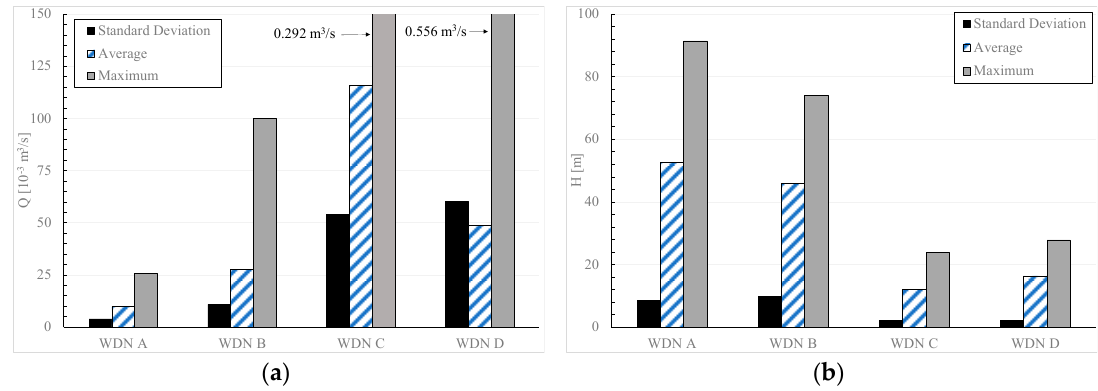
Figure 5. Summary of ( a ) volume flow rate and ( b ) head drop for WDN A, B, C and D.